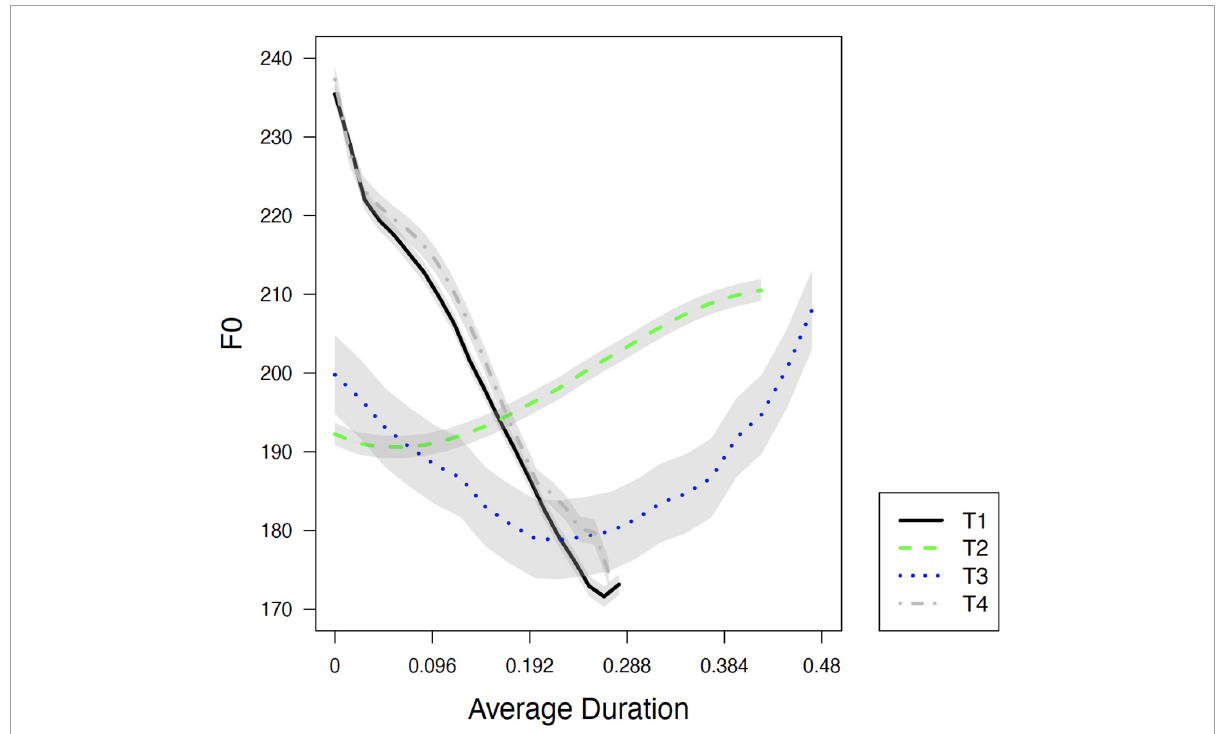
FIGURE1 Four lexical tones in present-day Dalian Mandarin produced in isolation, with each tonal contour based on 20 samples produced by a young male native speaker. Lines represent the mean. Shaded areas stand for the standard error of the mean ( ± 1.3 for T1, ± 1.4 for T2, ± 5 for T3, and ± 1.6 for